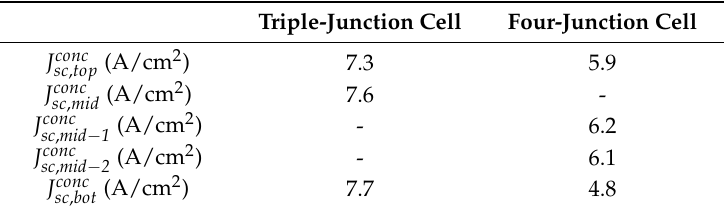
Table 3. Short-circuit current density values for all the subcells of both MJSC in the HCPV unit under normal alignment.